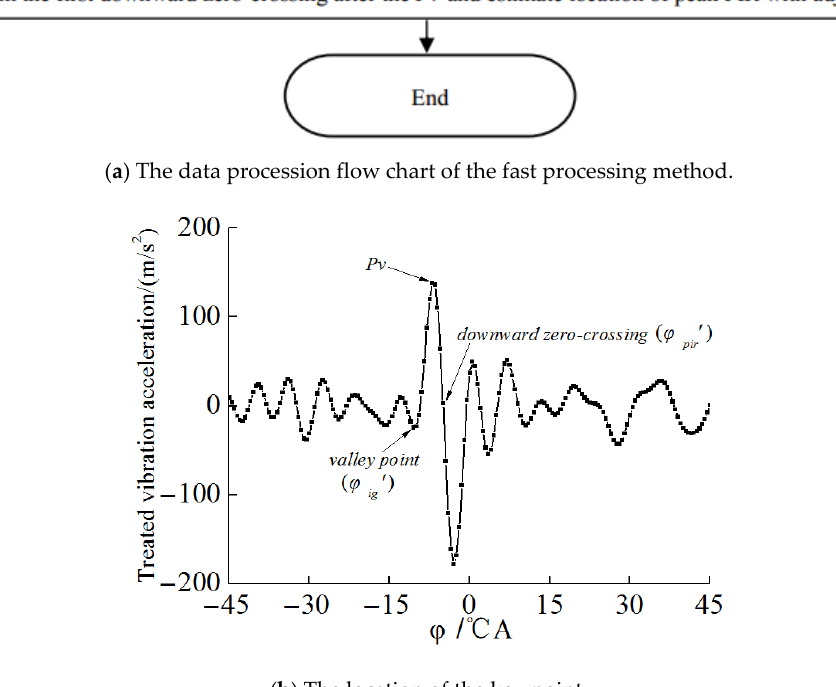
Figure 16. The data procession flow chart of the fast processing method and the location of the key points. To verify the processing speed and accuracy of the proposed method, consecutive cycles of vibration signals were processed to obtain the crank angles of SoC and the peak PIR at the engine speed of 1500 rpm and the power of 450 kW. The estimation deviations